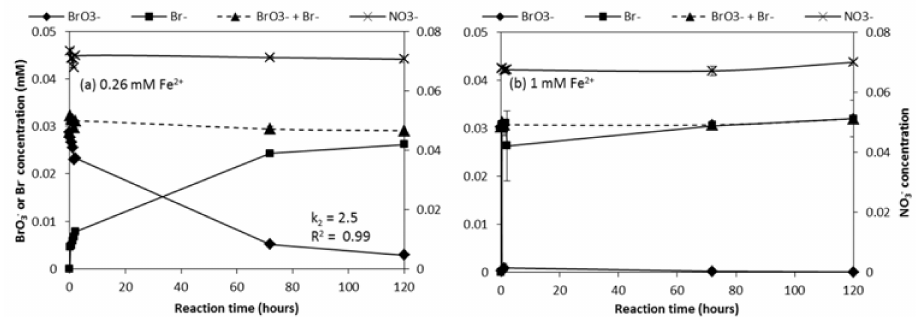
Figure 5. BrO 3 − reduction after dosing with ( a ) 0.26 mM or ( b) 1 mM Fe 2+ in the presence of NO 3 − . Initial BrO 3 − and NO 3 − concentrations were 0.03 mM and 0.07 mM, respectively, and initial pH was